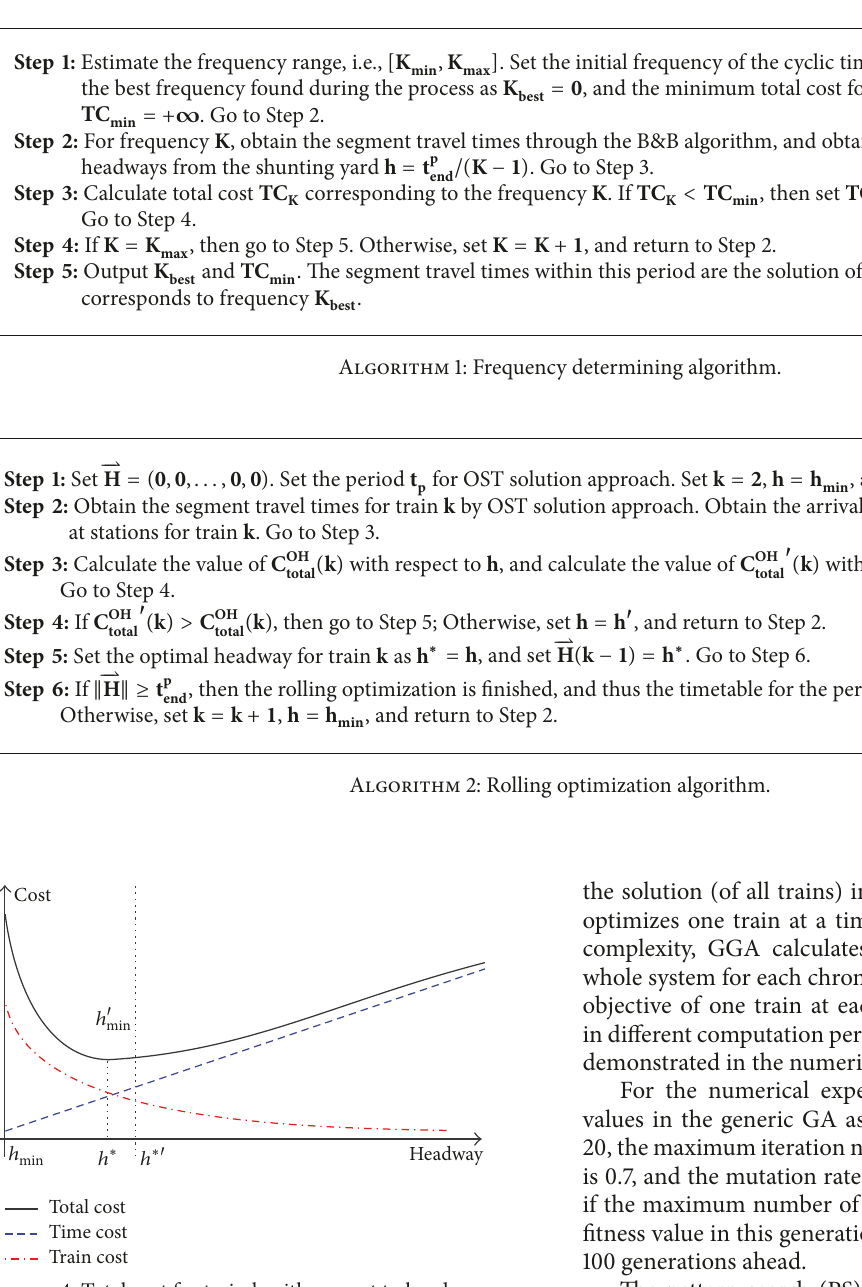
Figure 4: Total cost for train k with respect to